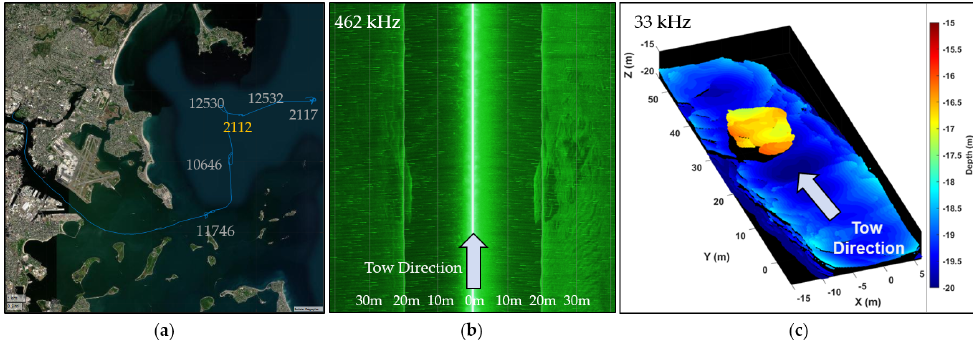
Figure 13. A comparison of seabed imagery of automated wreck and obstruction information system (AWOIS) site 2112, a sunken barge outside Boston Harbor. The site’s geolocation is indicated in ( a ). ( b , c ) Show reference imagery from a commercial side-scan sonar and imagery generated with our large sparse array using our initial low-resolution algorithm, respectively.